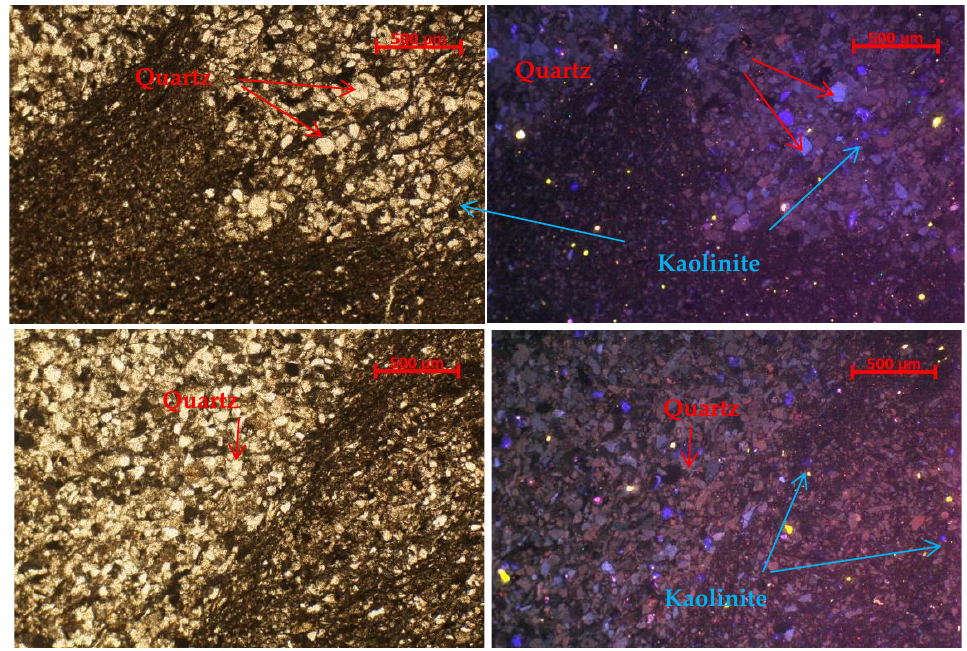
Figure 2. Cathodoluminescence picture near the beddings for slate.